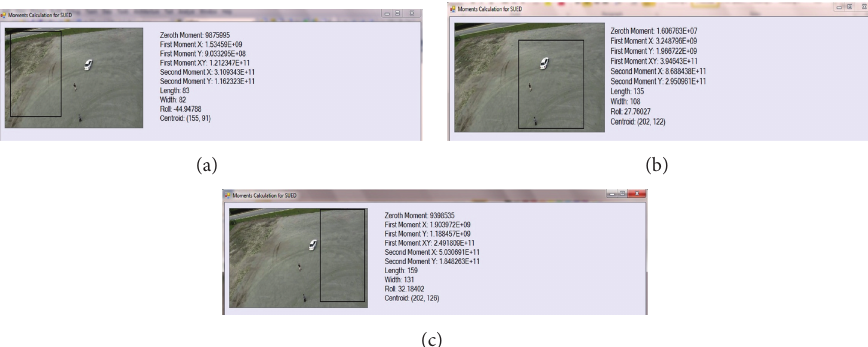
Figure 5: (a) Search window 1 for 𝐹𝐷(𝑚, 𝑛) in 𝑡 time. (b) Search window 2 for 𝐹𝐷(𝑚,𝑛) in 𝑡 time. (c) Search window 3 for 𝐹𝐷(𝑚,𝑛) in 𝑡 time.